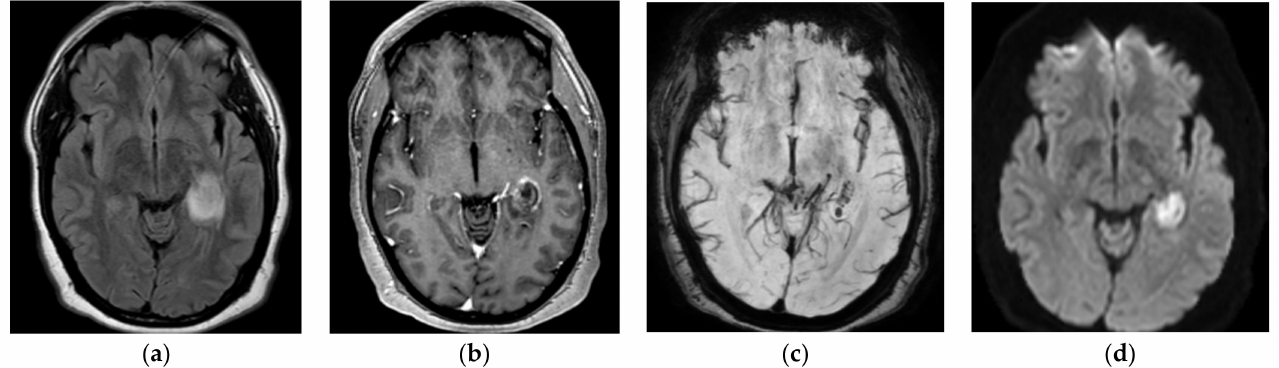
Figure 1. Hemorrhagic lesion in the left temporal lobe and parahippocampal gyrus. The lesion is hyper-intense on the FLAIR axial image ( a ). The lesion shows mild enhancement on the post-contrast T1 axial image ( b ). It shows a blooming artifact on susceptibility-weighted imaging (SWI) ( c ) image. The lesion shows restricted diffusion on the diffusion b 1000 ( d